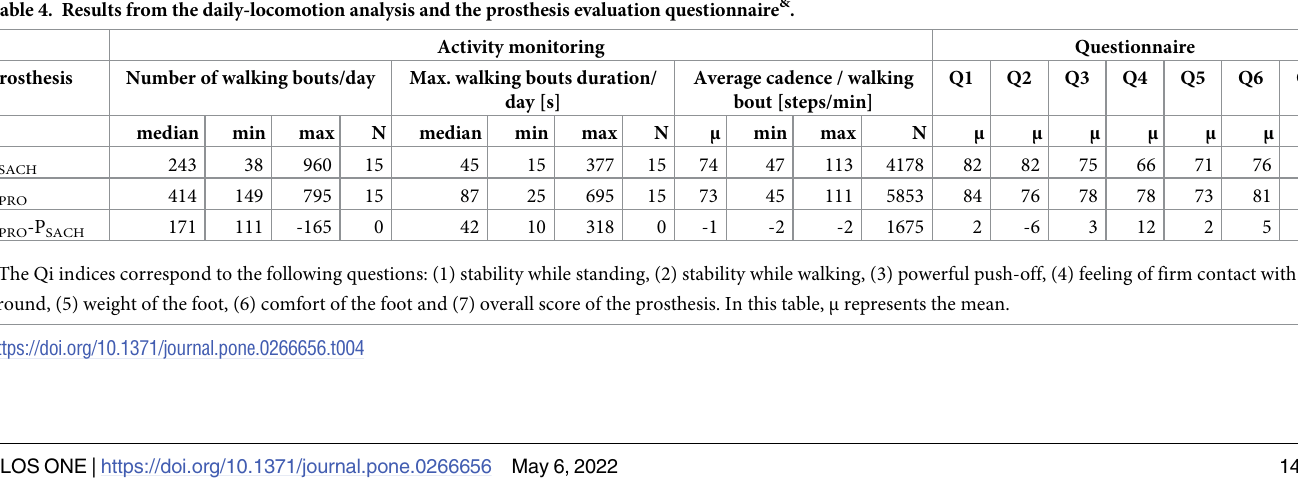
Table 4. Results from the daily-locomotion analysis and the prosthesis evaluation questionnaire & .